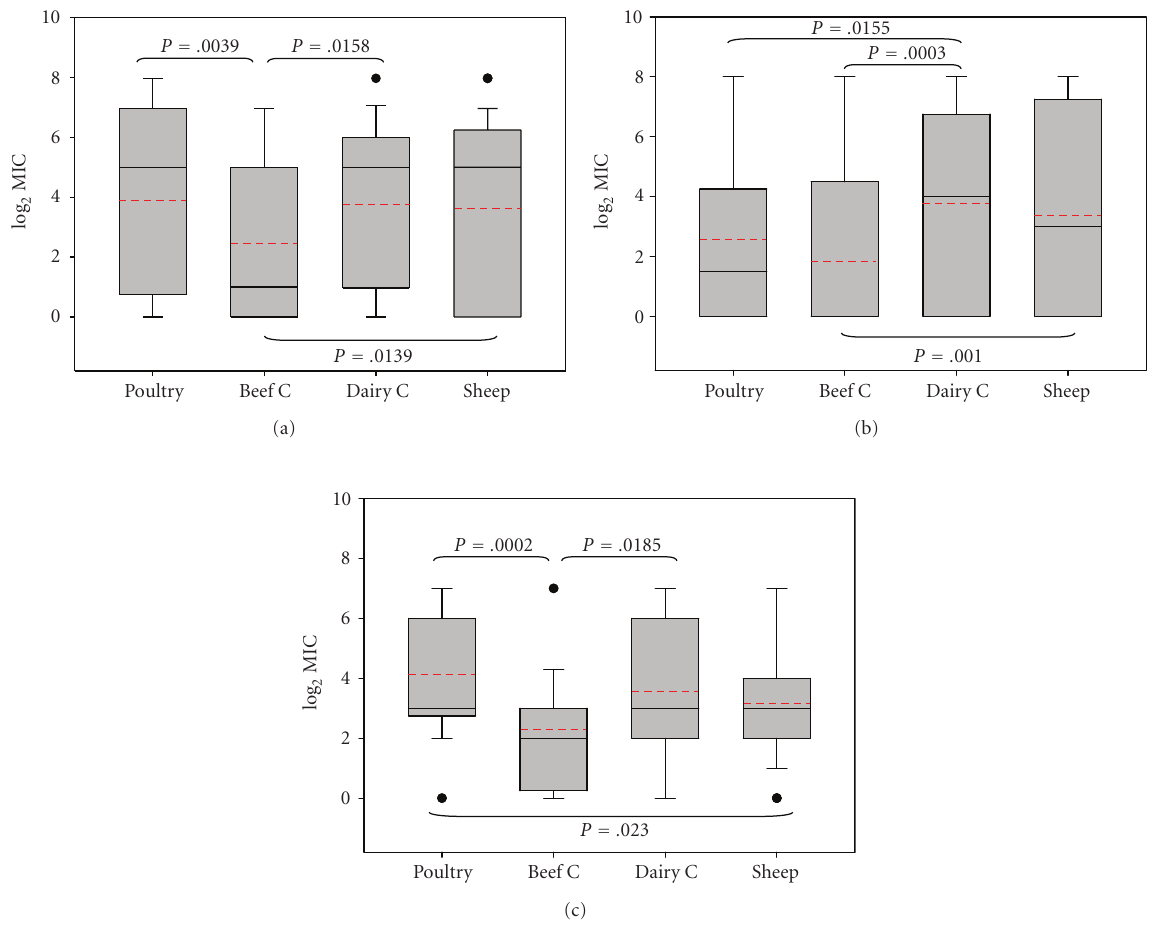
Figure 1: Box Plots representing log 2 -transformed MIC values distribution among host species for (a) Quinolones, (b) Tetracyclines, (c) β -lactams. To standardise MIC values for all antimicrobials, MICs were divided by the lowest value tested for each antimicrobial before log transformation. The boundary of the box closest to zero indicates the 25th percentile; the continuous line within the box marks the median; a dashed line marks the mean and the boundary of the box farthest from zero indicates the 75th percentile. Error bars above and below the box indicate the 90th and 10th percentiles. Outlying points are represented as closed dots. Significant di ff erences ( P < . 05) are indicated with their corresponding P